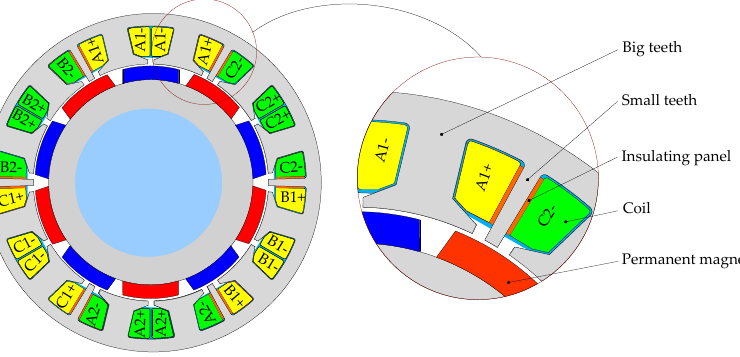
Figure 1. The cross-sectional view of the DRPMSM.